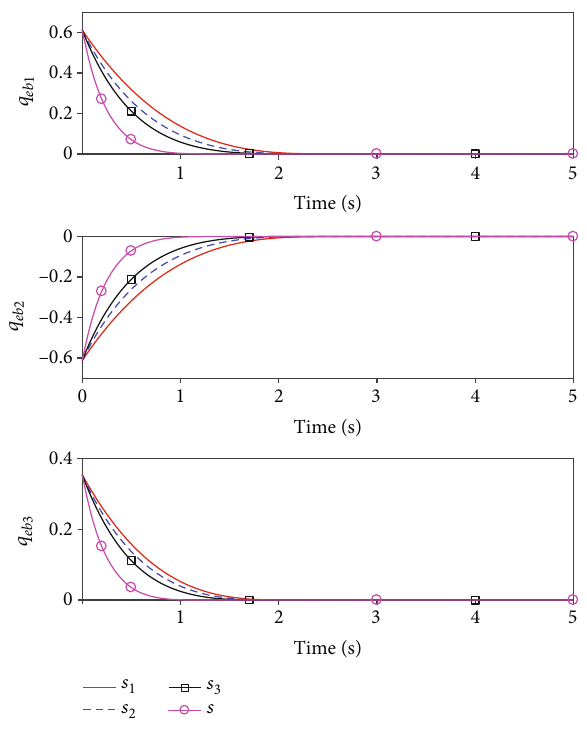
Figure 5: Convergence time